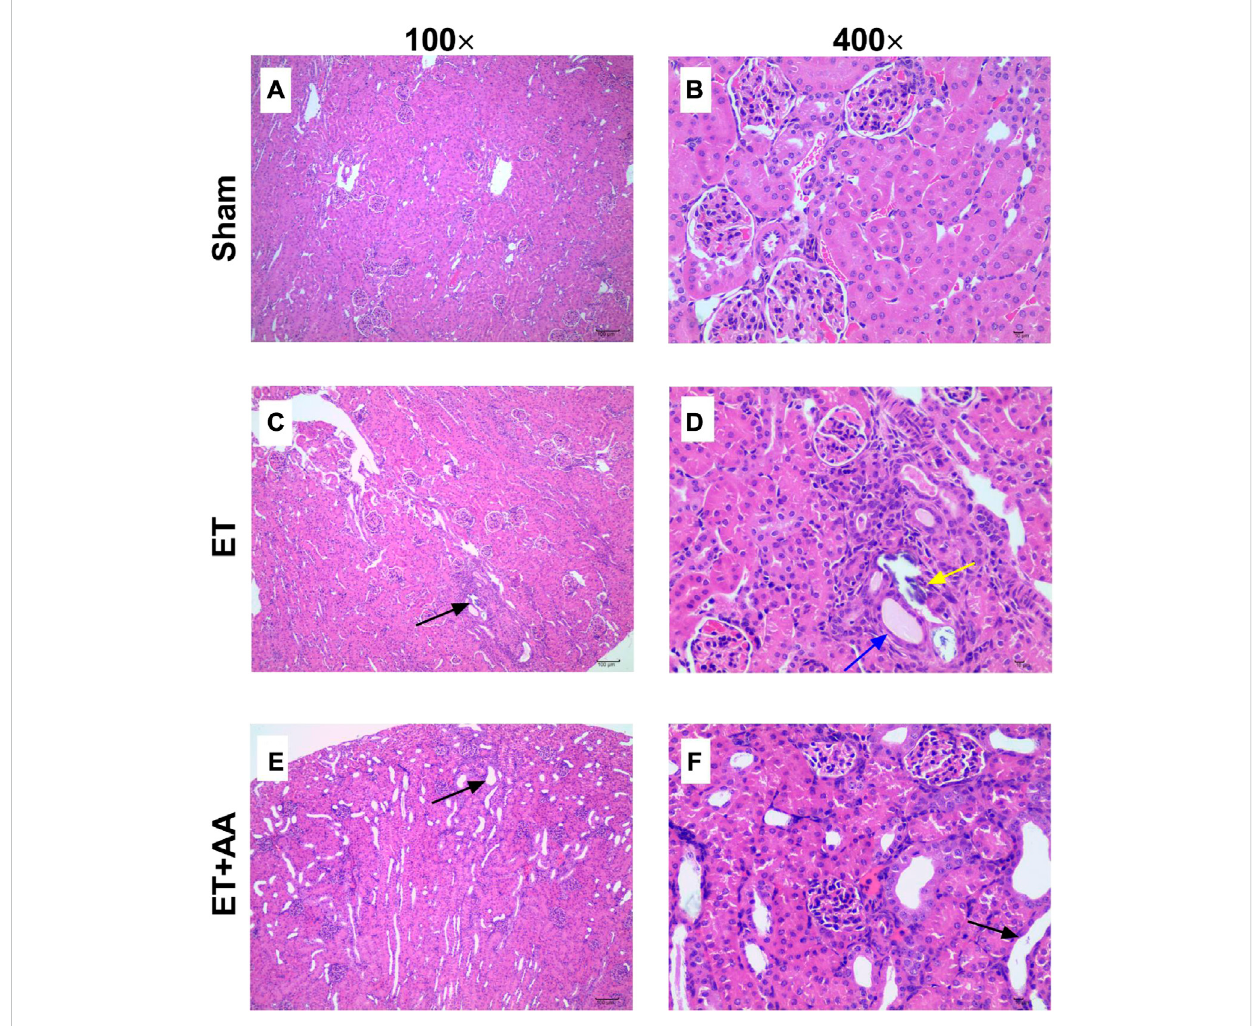
FIGURE 7 Kidneyhistopathologicalevaluationofguineapigsinthesham,ET,andET+AAgroups.Hematoxylinandeosin-stainedkidneyharvestedinthesham (A,B) , ET (C,D) , and ET + AA (E,F) groups. Magni fi cation at ×100 (A,C,E) and ×400 (B,D,F) . In the sham group, there was no histopathological changes. In the ETgroup, there was local tubular epithelial necrosis [ (C) , black arrow], glomerular micro thrombosis[ (D) , black arrow], tubular epithelial necrosis [ (D) , yellowarrow],andsquamousepithelium[ (D) ,bluearrow].IntheET+AAgroup,milddilationofrenaltubules[ (E) ,blackarrow)]and fl atepithelialcells [ (F) , black arrow] can be